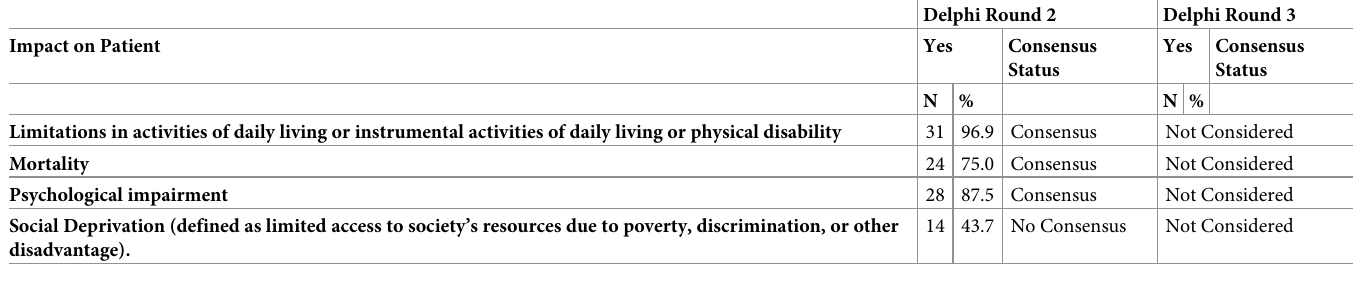
Table 3. Findings for parameters of ‘Impact on Patient’ for defining a chronic condition.